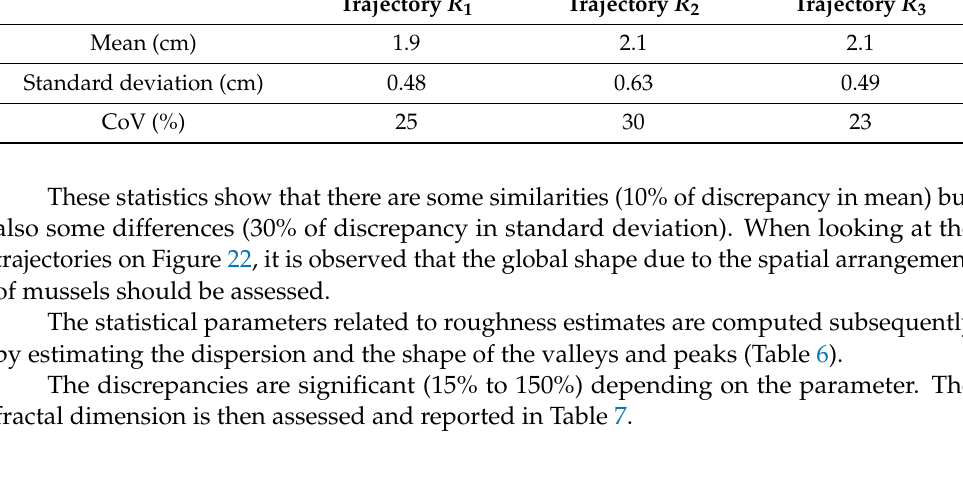
Table 6. Classical roughness parameter estimates.